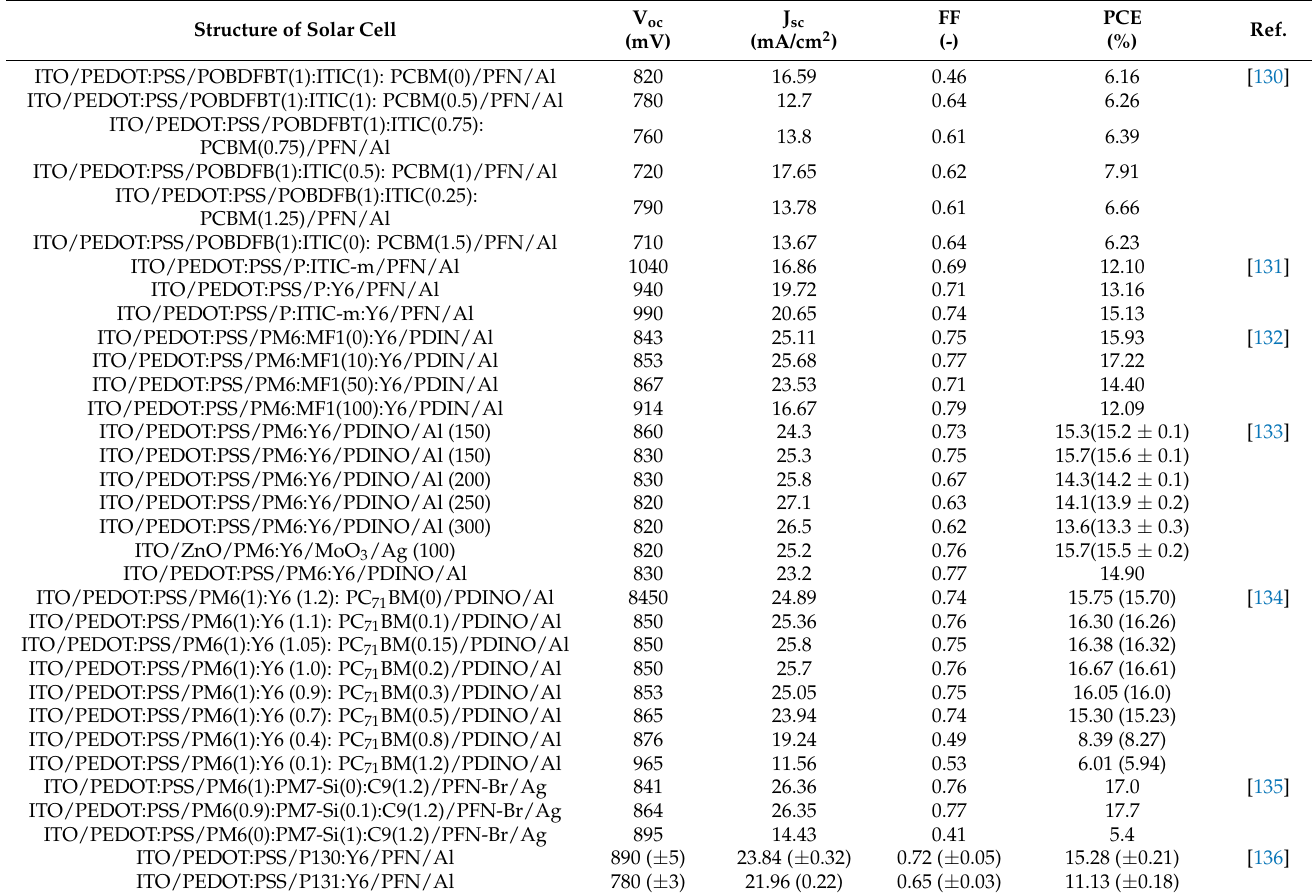
Table 6. Photovoltaic parameters of devices containing medium-bandgap polymers. Structure of Solar Cell